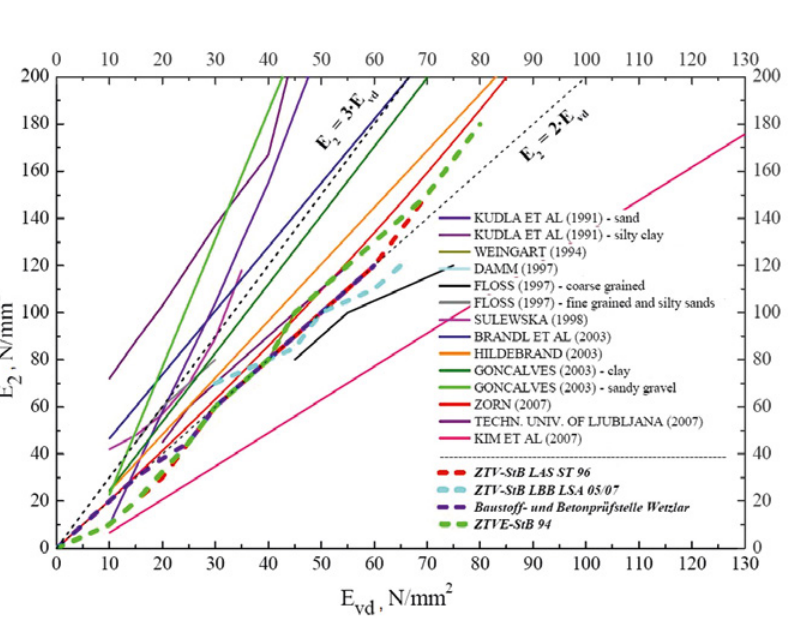
Figure 1. Correlation results of static and dynamic measuring